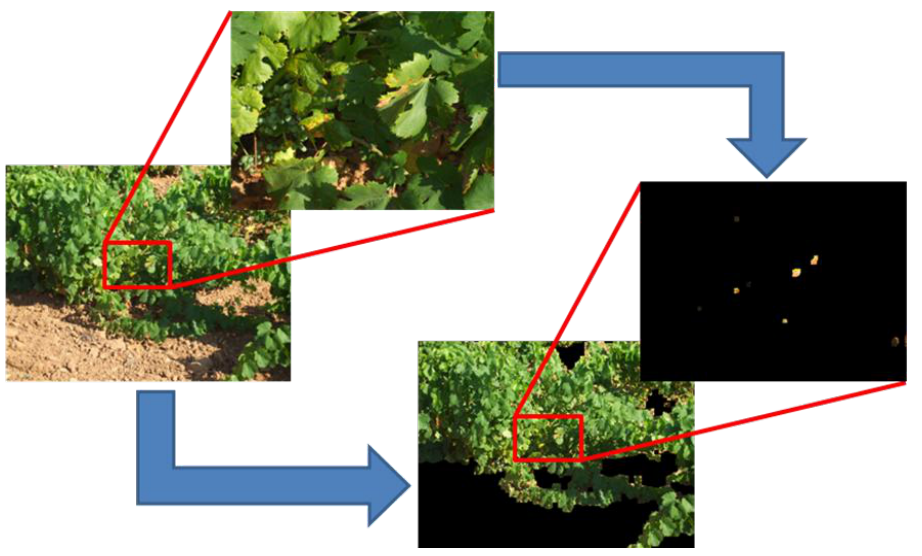
Figure 8. Detection of brown leaves in vines.